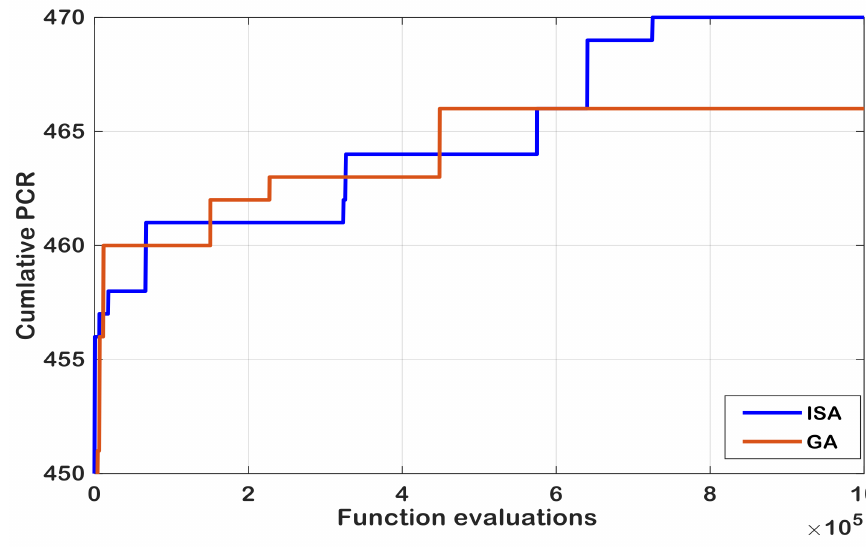
Figure 4. Convergence of the cumulative PCR for 3 years and 49 sections.